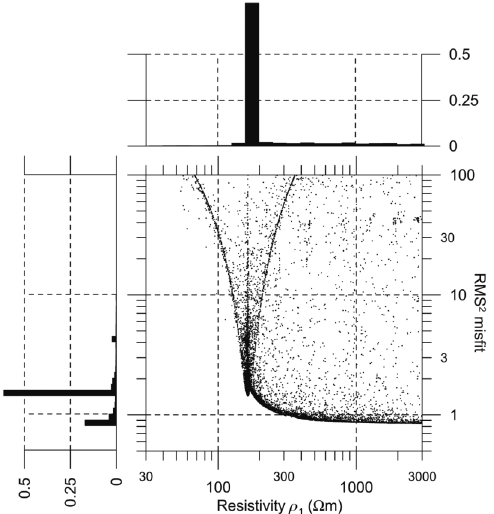
Fig. 4. Projection of all RMS 2 misfits versus the re- sistivity of the top layer obtained in the course of 20 CRS6 runs applied to the COPROD1 (DSII) data set with 3-layer test models. Along the axes, the corre- sponding histograms of the RMS 2 and ρ 1 values are